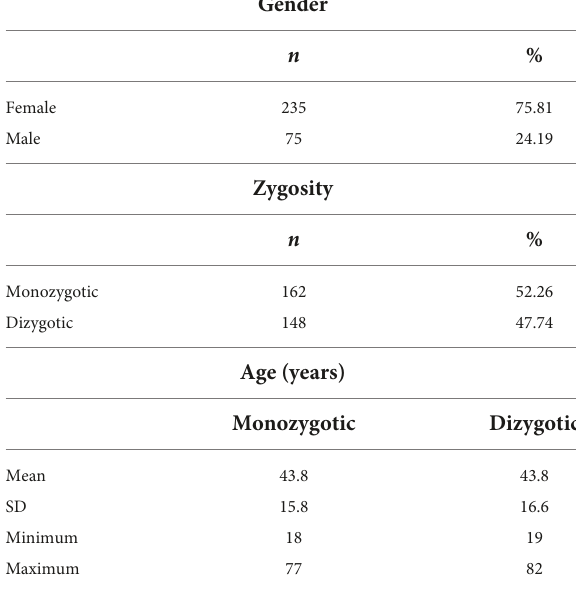
TABLE 2 Frequency of common symptoms following SARS-CoV-2 infection within